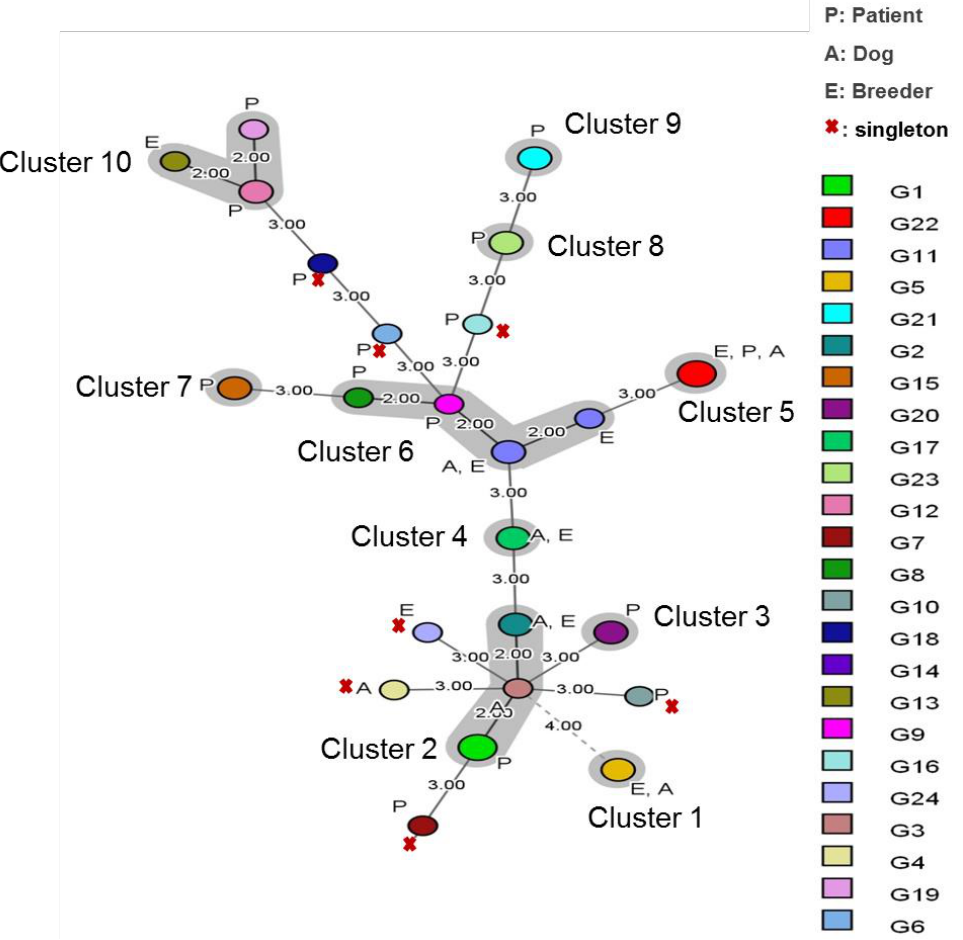
Figure 3. Minimum spanning tree showing the genotypic diversity of Malassezia globosa isolates (N = 44) based on VNTR data. Each circle shows a unique genotype and its size, the number of strains belonging to the same genotype. Connecting lines and numbers between circles show the similarity between genotypes: (1.00) indicates only one marker difference, (2.00) indicates a difference in two markers and (3.00) the difference in three markers.